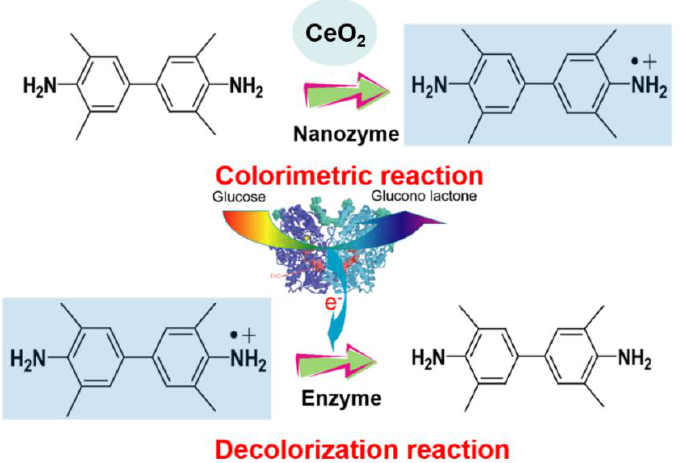
Figure 1. Schematic illustration for the CeO 2 -based catalyzed oxidation of TMB to yield blue oxTMB product and GOx-based decolorization.